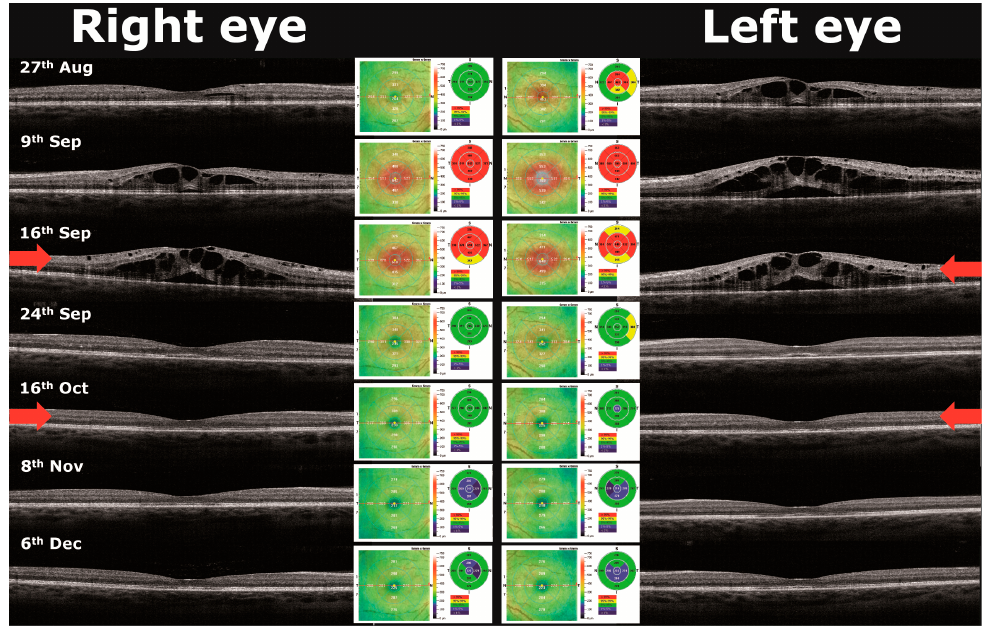
Figure 2. Results of the spectral-domain optical coherence tomography examinations. Spectral-domain optical coherence tomography scans through the fovea show development of severe macular edema with intraretinal und subretinal fluid and its rapid resolution after intravitreal injection of an anti-vascular endothelial growth factor (VEGF) agent into each vitreous cavity of both eyes on 16 September 2013. On 24 September 2013 optical coherence tomography (OCT) shows residual alterations of the outer retina on both eyes. Red arrows mark the intravitreal injection.